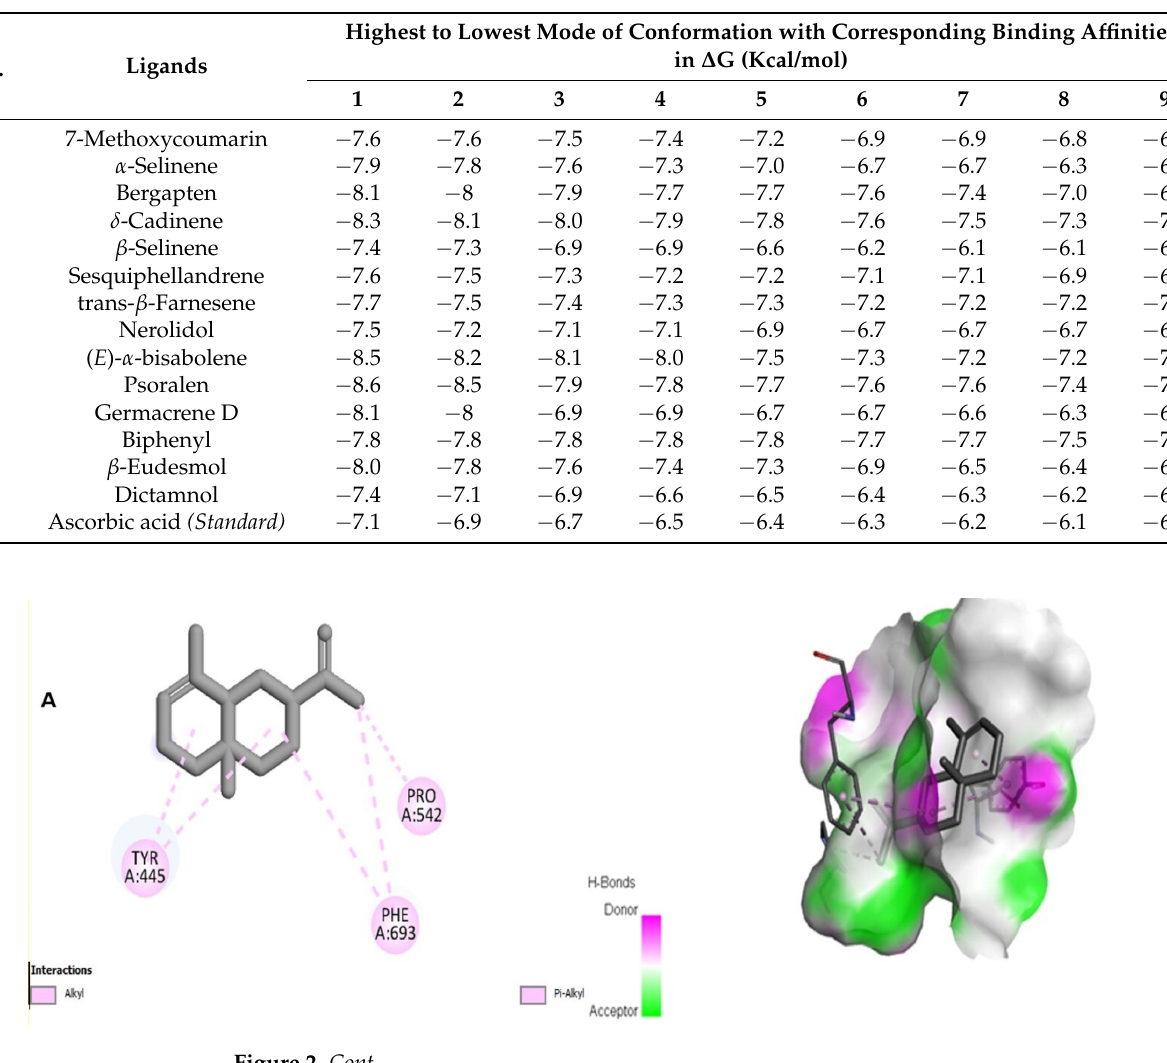
2.3. In-Silico Study for the Phytoconstituents in Essential Oil